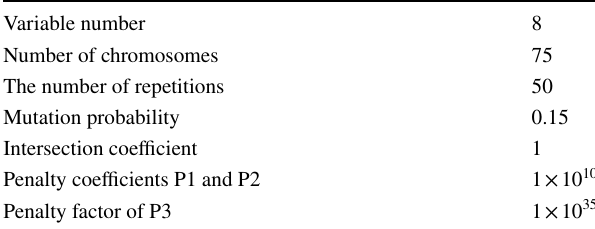
Table 4 NSGA-II parameters used for optimal design of